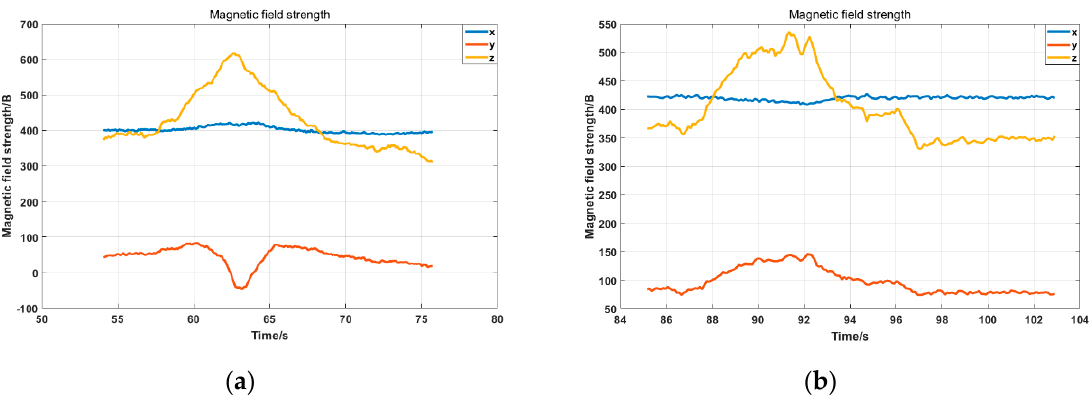
Figure 12. Output of triaxial magnetometer: ( a ) triaxial magnetic field data under large interference; and ( b ) triaxial magnetic field data under small interference.